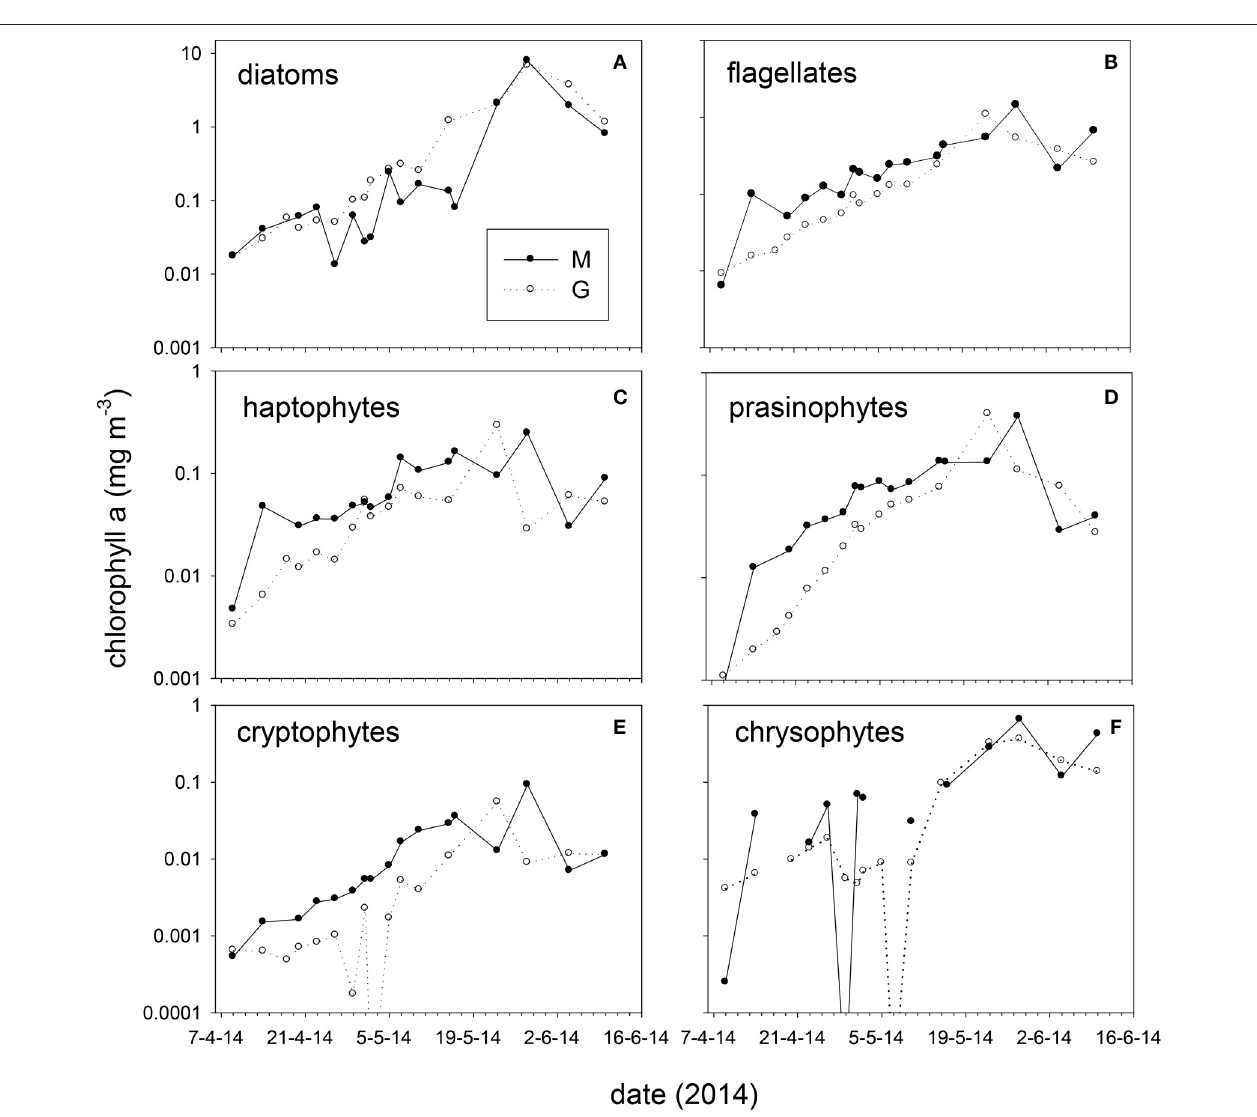
FIGURE 6 | Absolute chlorophyll-a concentration (average 5, 25m) of taxonomic groups at stations M and G from April to June 2014. (A) diatoms, (B) total flagellates (prasinophytes, haptophytes, chrysophytes, cryptophytes, and dinoflagellates combined), (C) haptophytes, (D) prasinophytes, (E) cryptophytes, and (F) chrysophytes. Note the difference in scale between